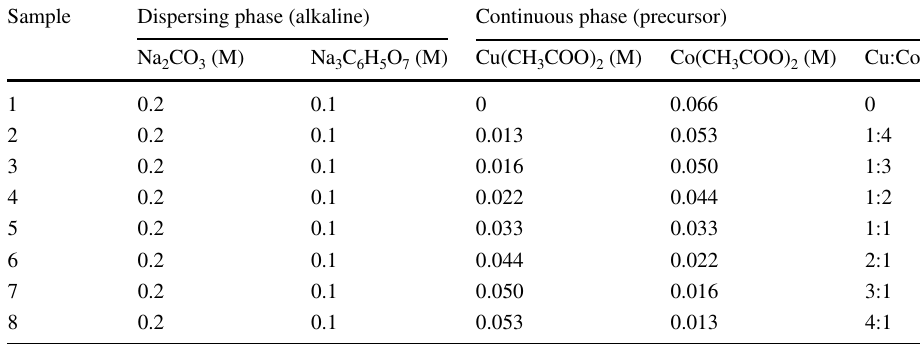
Sample Dispersing phase